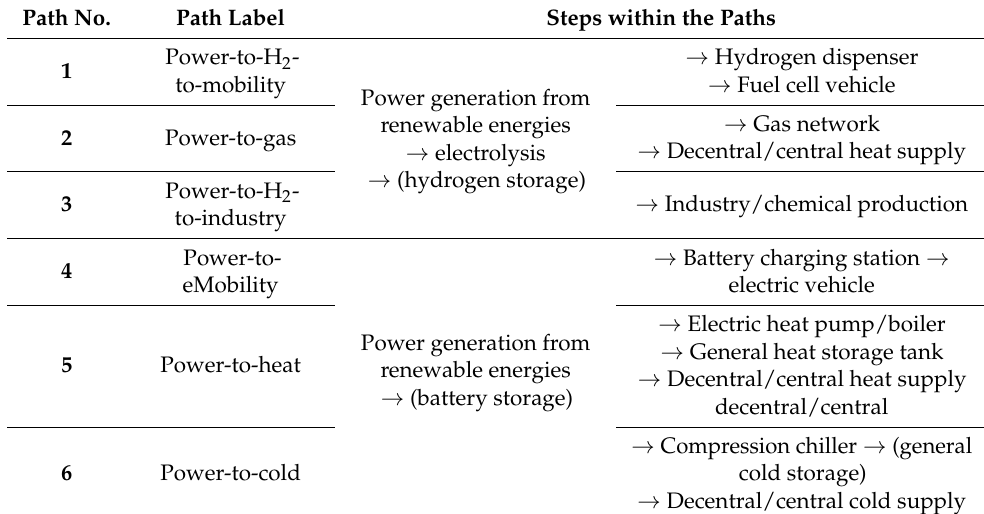
Table 1. Overview of six selected paths and their steps. Path